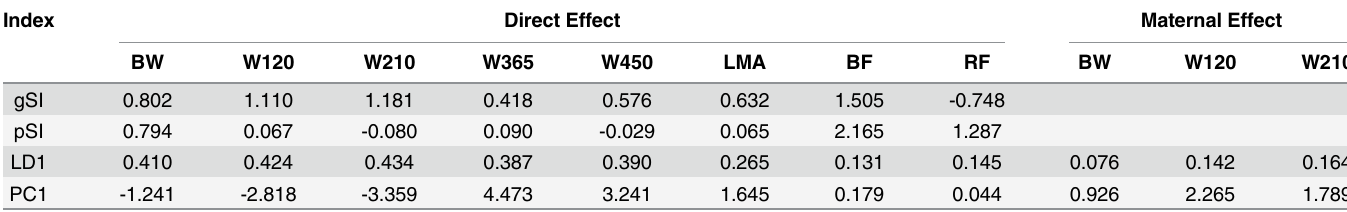
Table 10. Weights of indices based on selection index and the multivariate approach.